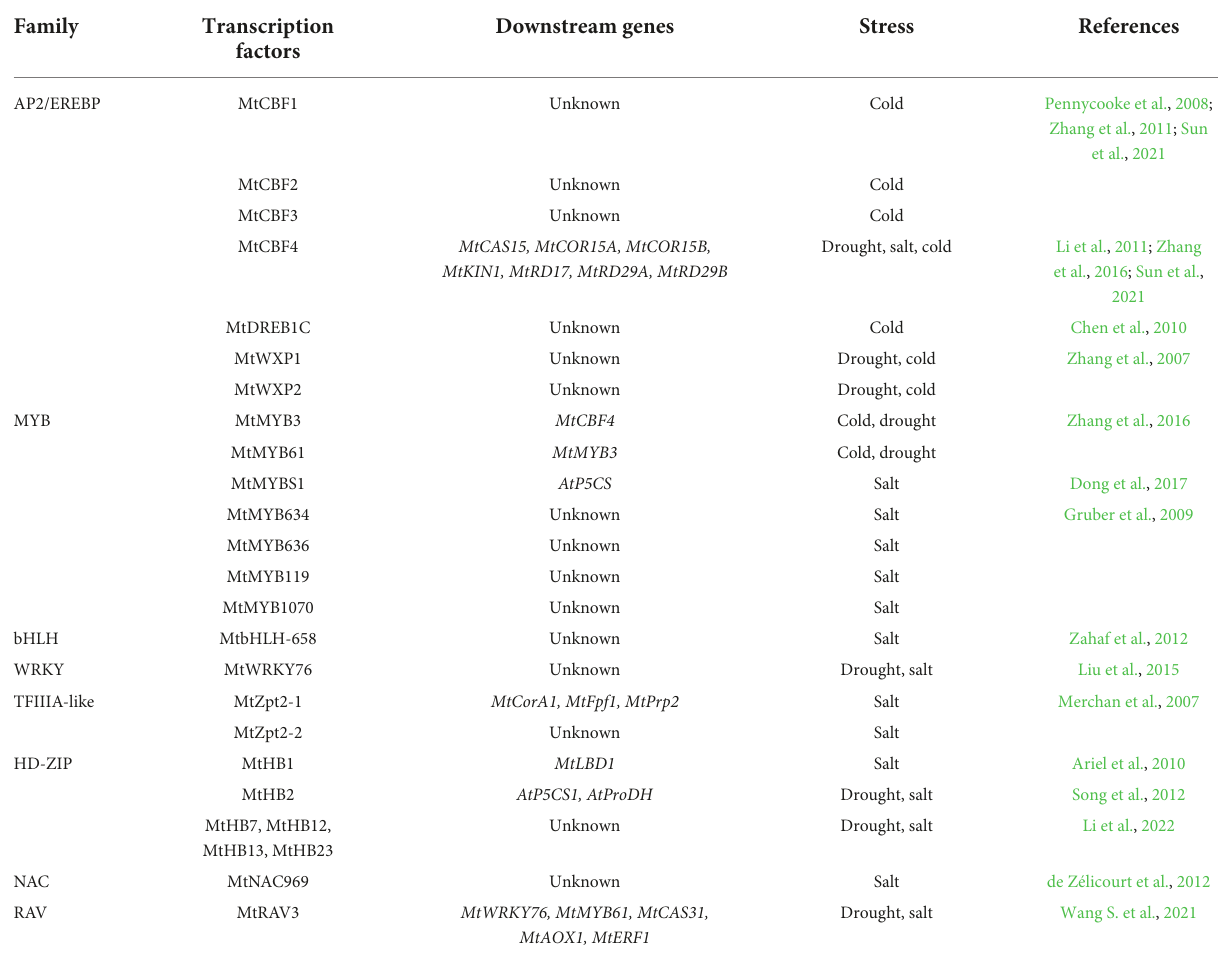
TABLE 1 TFs of M. truncatula involved in drought, salt, and cold stress.